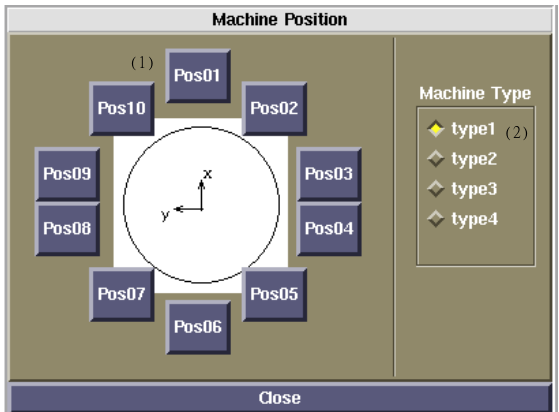
Figure 4. Layout panel. By specifying the four types of microrobots with different weights at each position on the layout panel, the microrobots can be placed arbitrarily. Microrobot type 1: driving microrobot (master), weight: 0.508 g; microrobot type 2: driving microrobot (slave), weight: 0.508 g; microrobot type 3: flaw-detection microrobot (non-driving), weight: 0.318 g; microrobot type 4: transmission microrobot (non-driving), weight: 0.304 g.